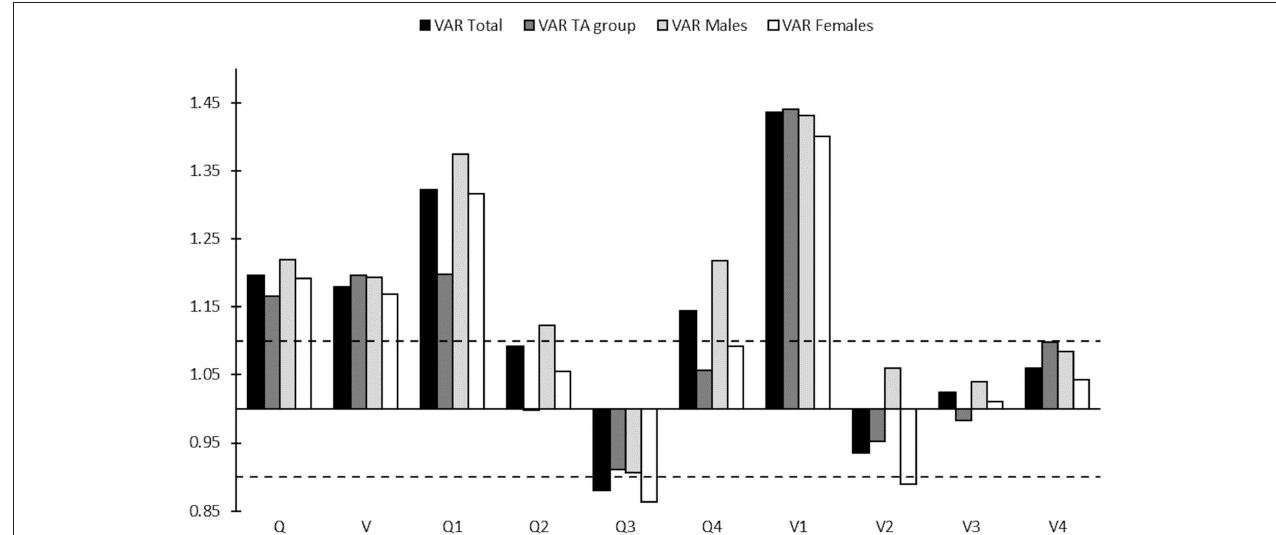
FIGURE 2 | 16A Value added ratio (VAR) for the different subgroups and the total population on all subtests and both sections (Quantitative and Verbal) of the test. Threshold values, indicating the interval for redundant subscores (between 0.9 and 1.1), are displayed as dotted horizontal